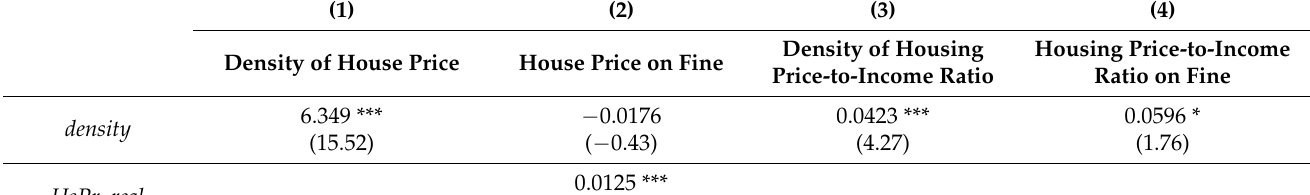
Table 5. Mechanism tests: impact of density on credit